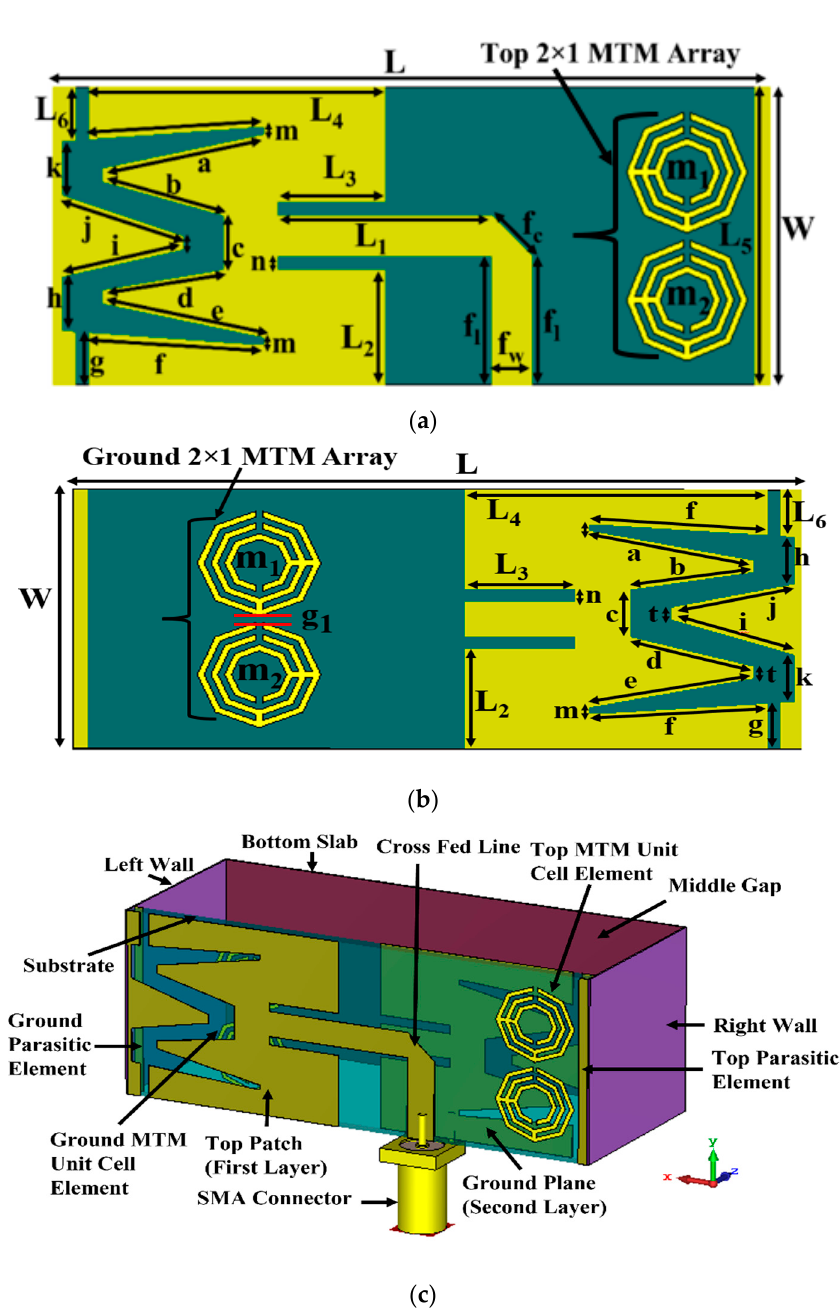
Figure 1. Graphic diagram of the 3D antenna sensor: ( a ) top view, ( b ) bottom view, ( c ) perspective view.